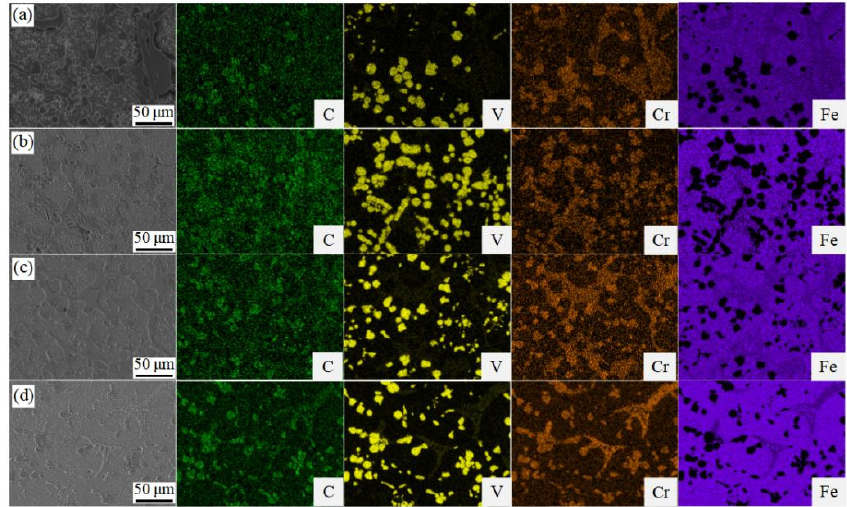
Figure 2. Main alloying elements’ distribution of the VCFC with different heat-treated processes. ( a ) QP, ( b ) QPT, ( c ) MQP, ( d ) MQPT.